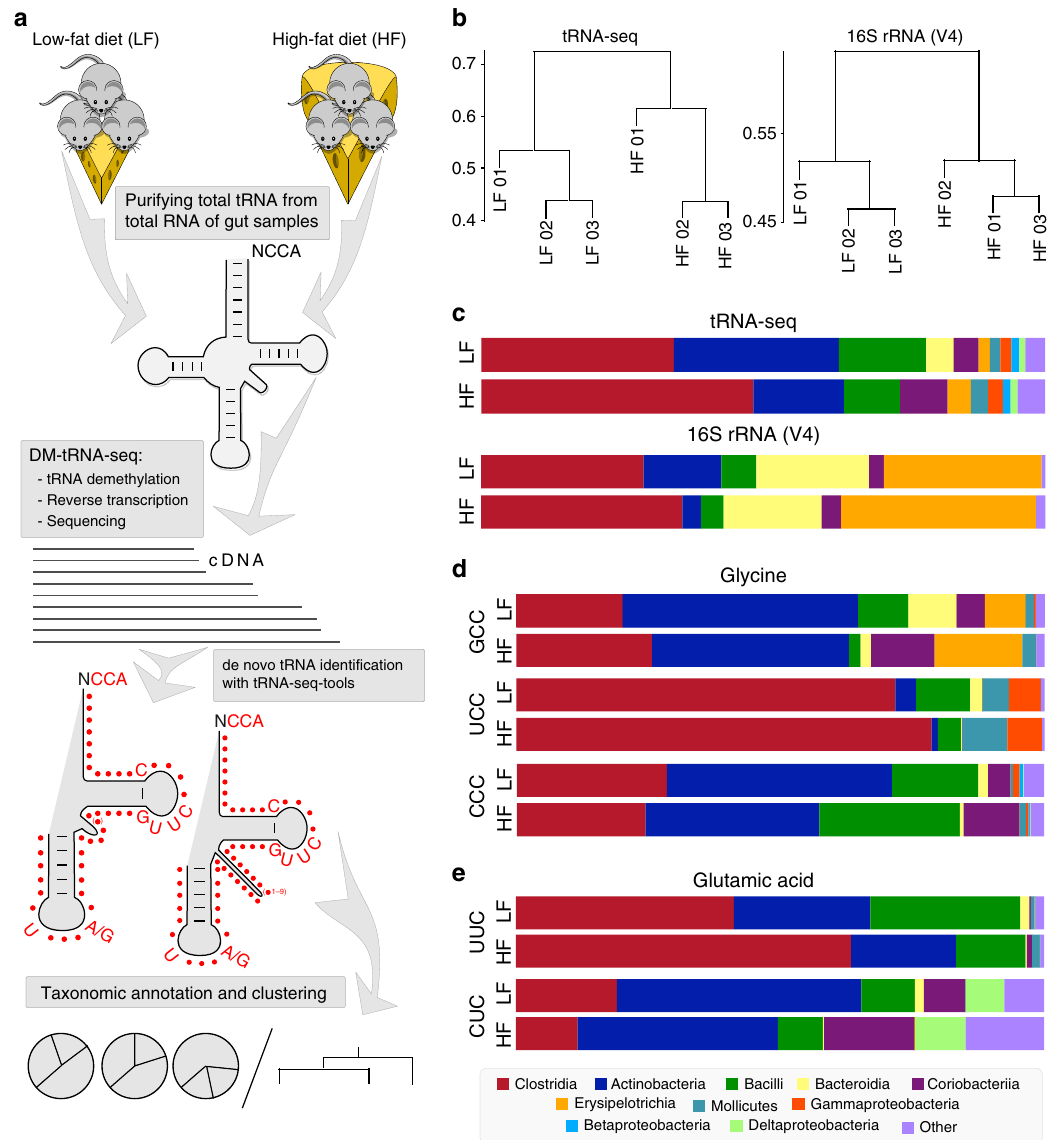
Fig. 3 Microbiome tRNA-seq work fl ow and taxonomy analysis. a Work fl ow of tRNA sequencing of gut microbiome samples fed with a high-fat (HF) or low- fat (LF) diet and de novo tRNA assignment. Conserved tRNA residues that were searched for in this work are shown in red. b Dendrograms compare relationships between HF and LF samples that were inferred based on community pro fi les of tRNA transcripts, or 16S rRNA gene amplicons. c Class-level taxonomy for averaged HF and LF samples based on tRNA-seq (top) and 16S rRNA gene amplicons (bottom). All bacterial classes at >1% level are shown in distinct colors, all other bacterial classes are grouped together and shown in purple. d tRNA Gly taxonomy for anticodons GCC, UCC, and CCC. e tRNA Glu taxonomy for anticodons UUC and CUC. Among the other category for GCC/UCC/CCC and UUC, no class has an abundance of ≥ 1%; for CUC, other classes with an abundance of ≥ 1% include Alphaproteobacteria, Gemmatimonadetes, and Ignavibacteria. tRNAs decoding these two amino acids are